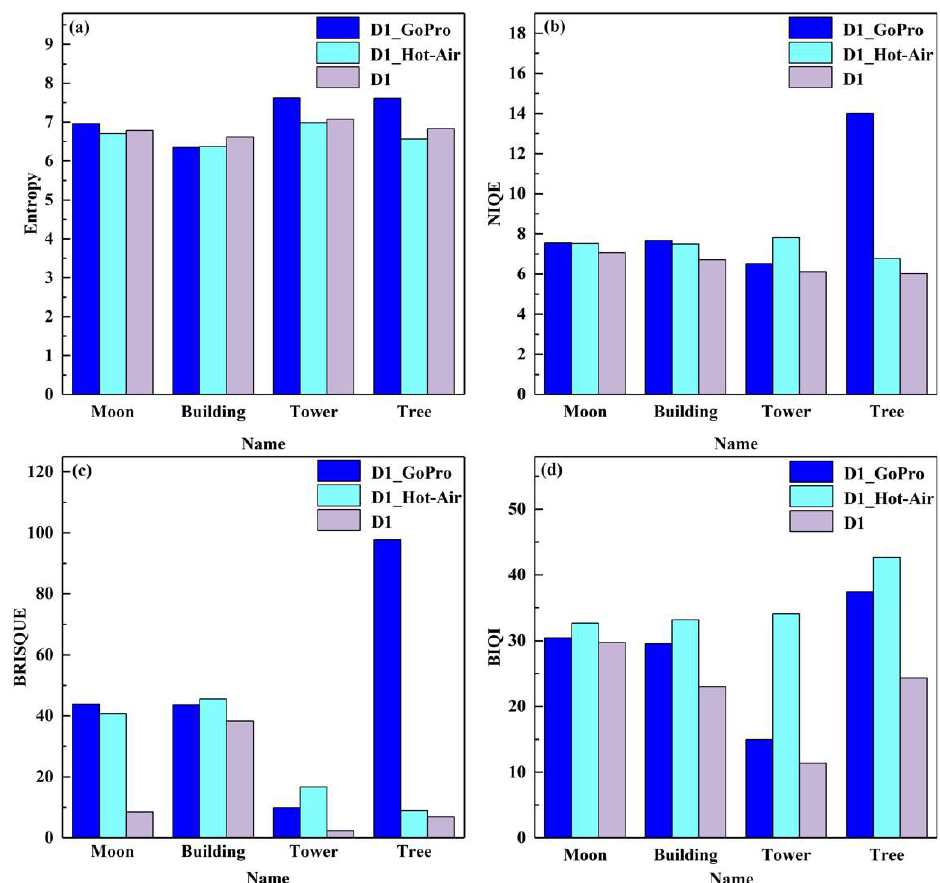
Figure 11. Evaluation of the ablation experiment results using the non-reference indexes.